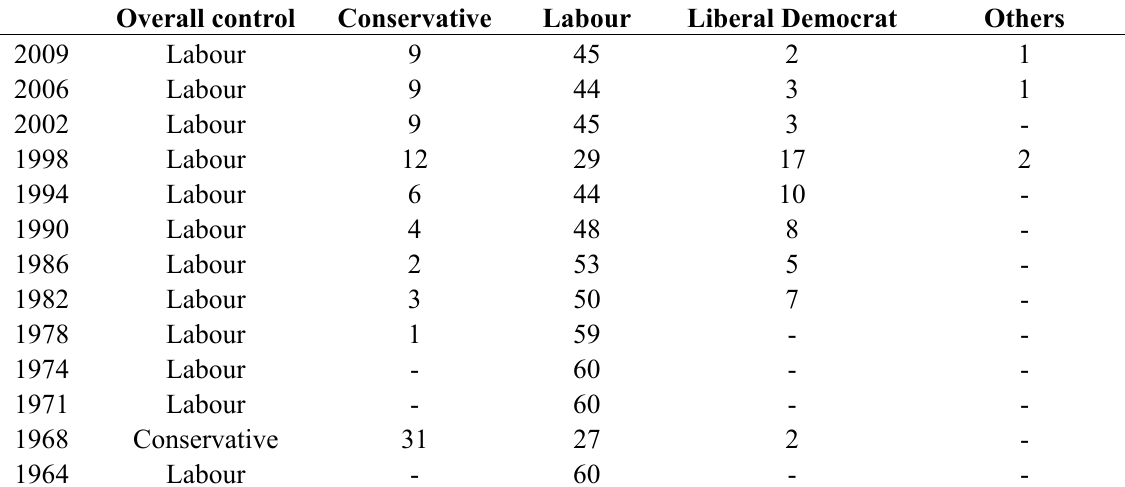
Table 5. Composition of Hackney Council, 1964–2009.